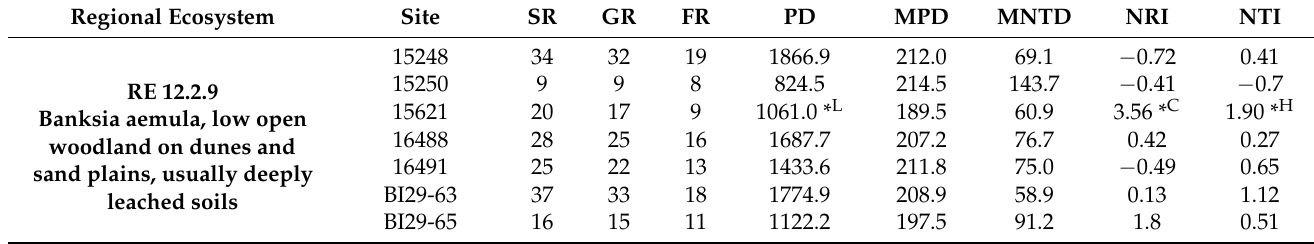
Figure 3. Phylogenetic position of the Regional Ecosystems represented against the phylogenetic tree of the Sunshine Coast heath site taxa. Table 3. Phylogenetic metrics of each of the 80 study sites, grouped by regional ecosystem.